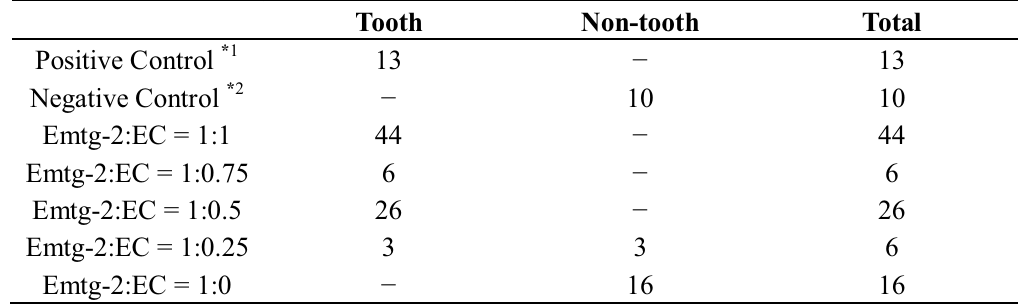
Table 2. Tissues grown from tooth germs reconstructed with emtg-2 cells and EC (1:1~0) and MT on culture